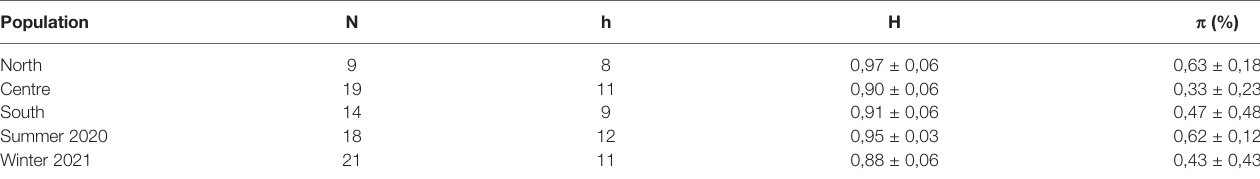
TABLE 3 | Sample sizes and standard diversity indices for partial mtCOI sequences of Rhopilema nomadica sampled at three locations (North, Centre and South) and two seasons (summer 2020 and winter 2021). Population